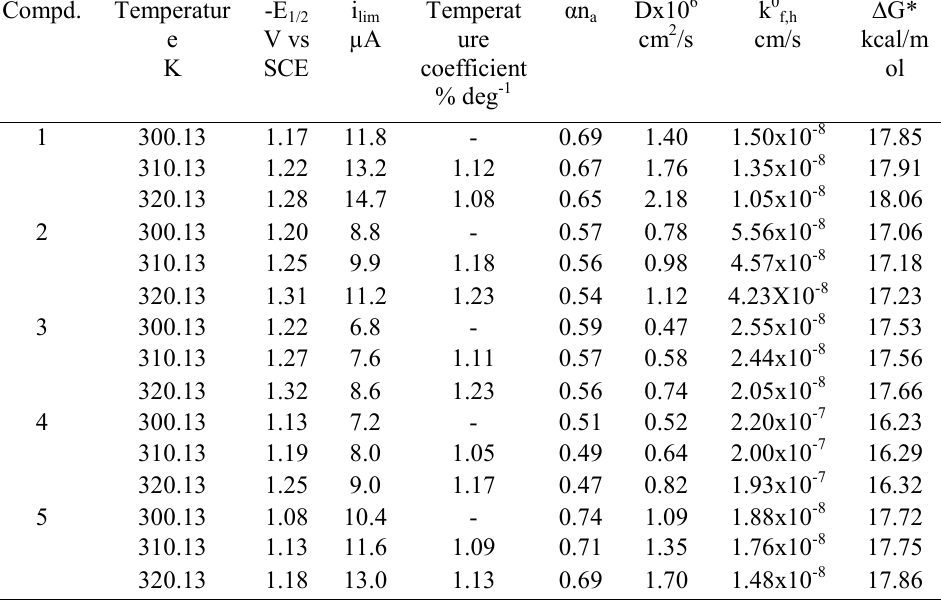
Table 7. Effect of temperature on the polarographic characteristicsof compounds 1-5